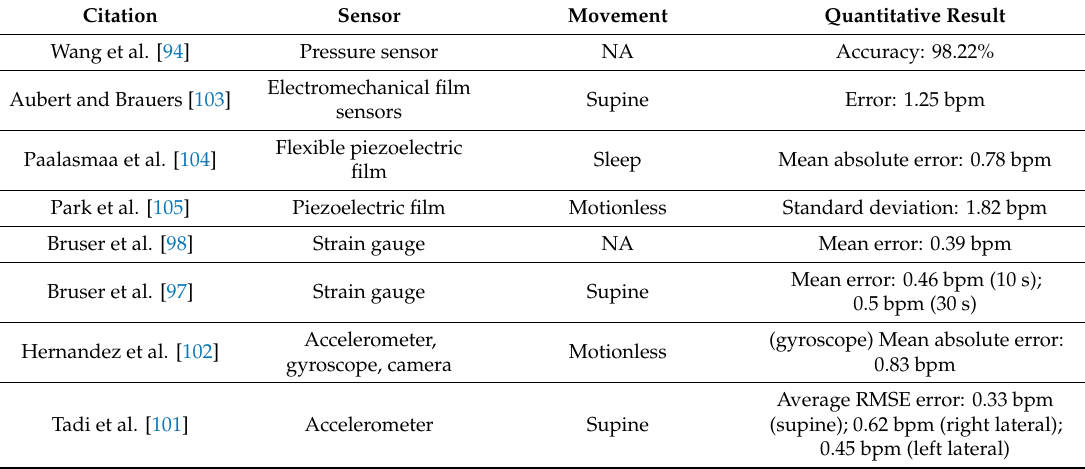
Table 9. Summary of Ballistocardiography (BCG) and Seismocardiography (SCG) measurements for HR